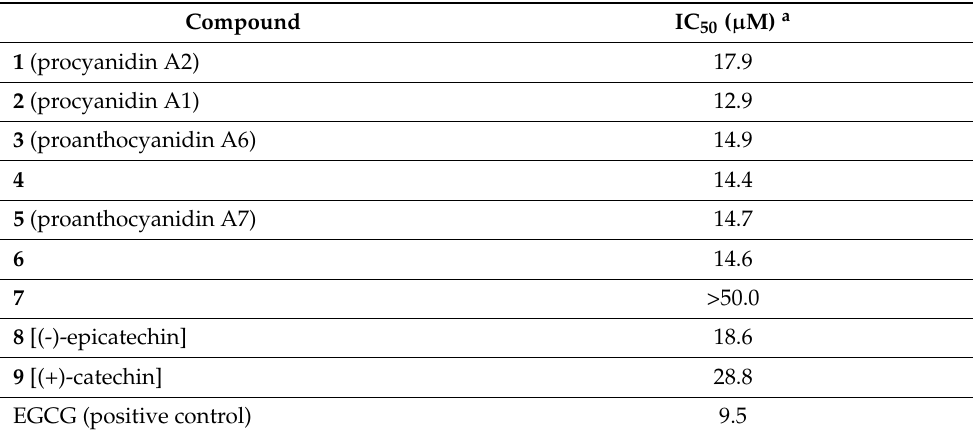
Table 3. Efficacy of compounds 1 – 9 against DPPH free radical.